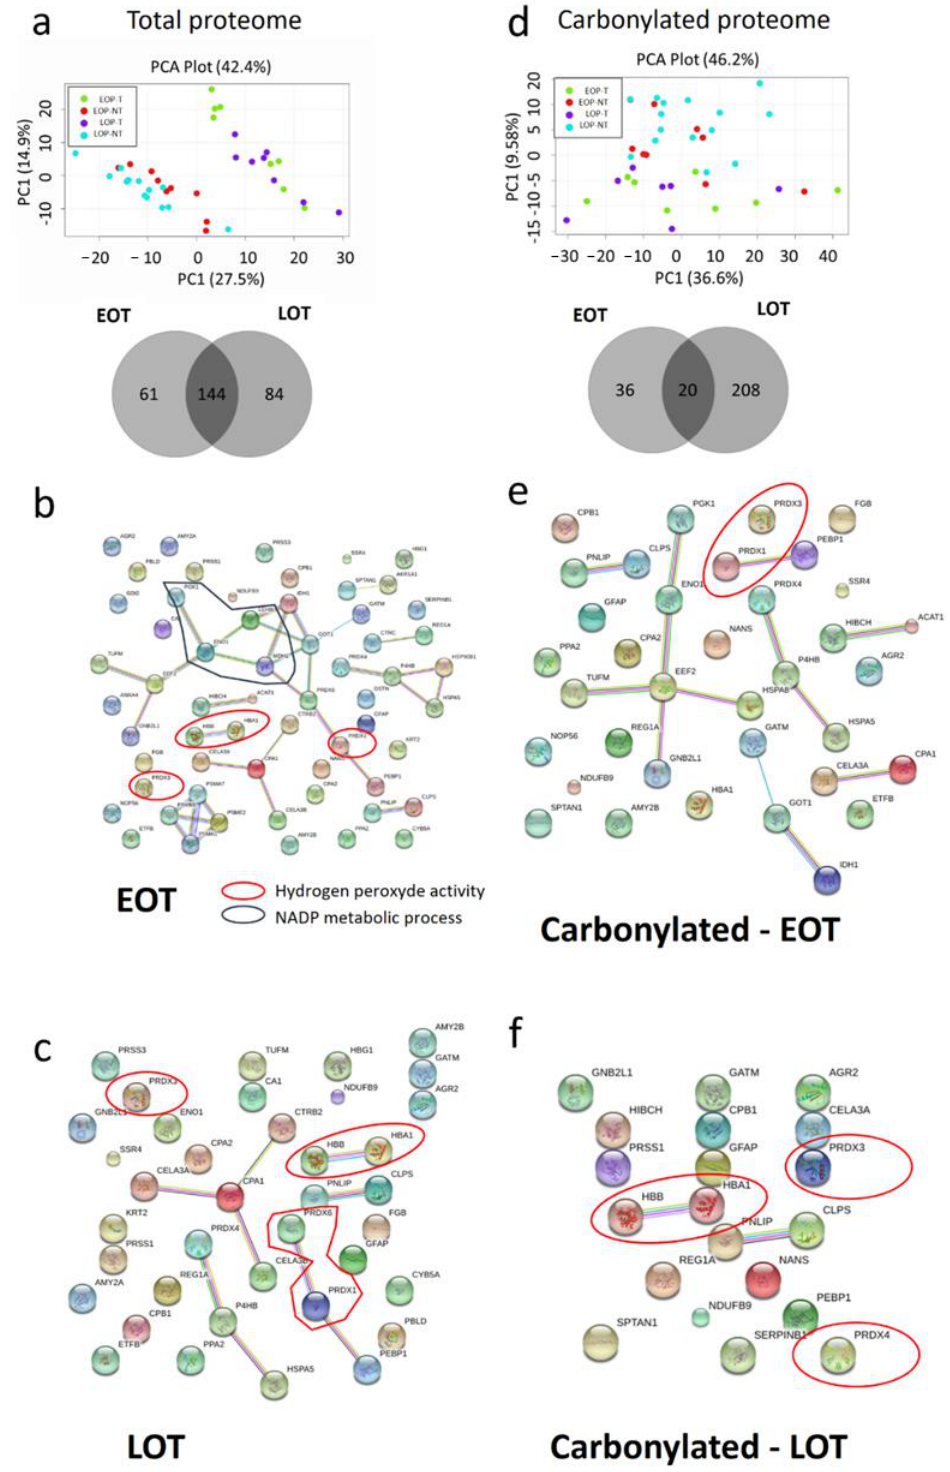
Figure 4. Specific protein damages in tumor tissues (T) compared to non-tumor tissues (NT) in early-onset patients (EOP) and late-onset patients (LOP). ( a ) Principal component analysis (PCA) of total protein expression from each spot analyzed by 2D-DIGE. Lower panel: Venn diagram of specific spots from EOP and LOP, ( b ) PCA of carbonylated protein expression from each spot analyzed by 2D-DIGE. Lower panel: Venn diagram of specific spots from EOP and LOP. ( c – f )—String software analysis of significant differential proteins ( c ) Down regulated in EOP; ( d ) Down regulated in LOP; ( e ) More carbonylated in EOP; ( f ) More carbonylated in LOP.